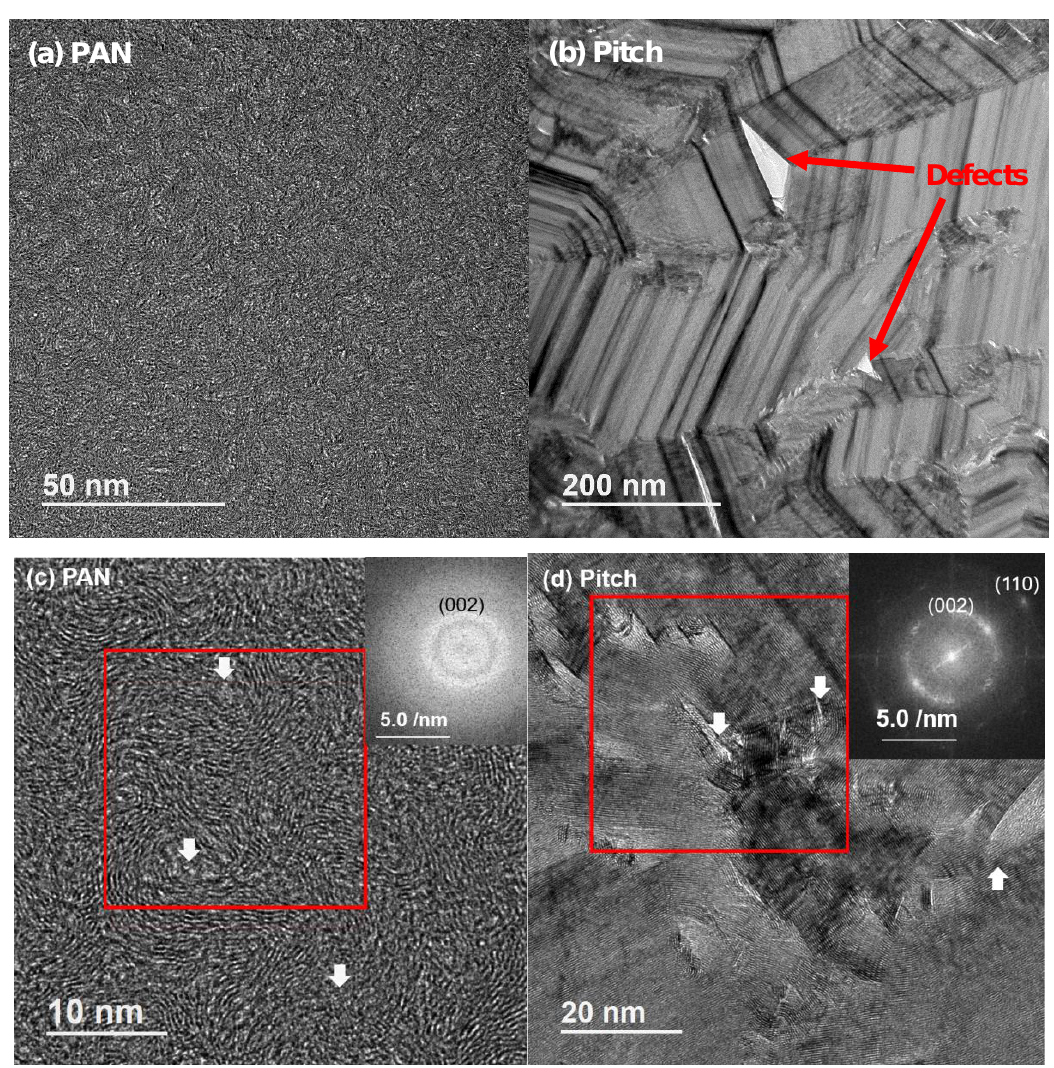
Figure 2. Cross-sectional TEM images of ( a , c ) PAN and ( b , d ) pitch-based carbon fiber at different magnifications. The inset shows FFT image of the squared area. The graphitic structure is more evident in the case of pitch fiber. Triangular defects between each crystalline structure can be seen in the pitch-based fiber.